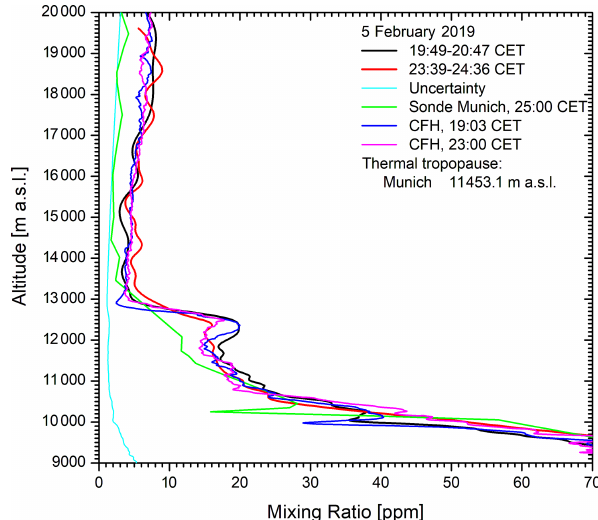
Figure 16. A close-up portion of Fig. 20: the agreement between the lidar and the CFH is satisfactory up to almost 20km. Above this, the lidar values start wider excursions around the CFH mixing ratios.